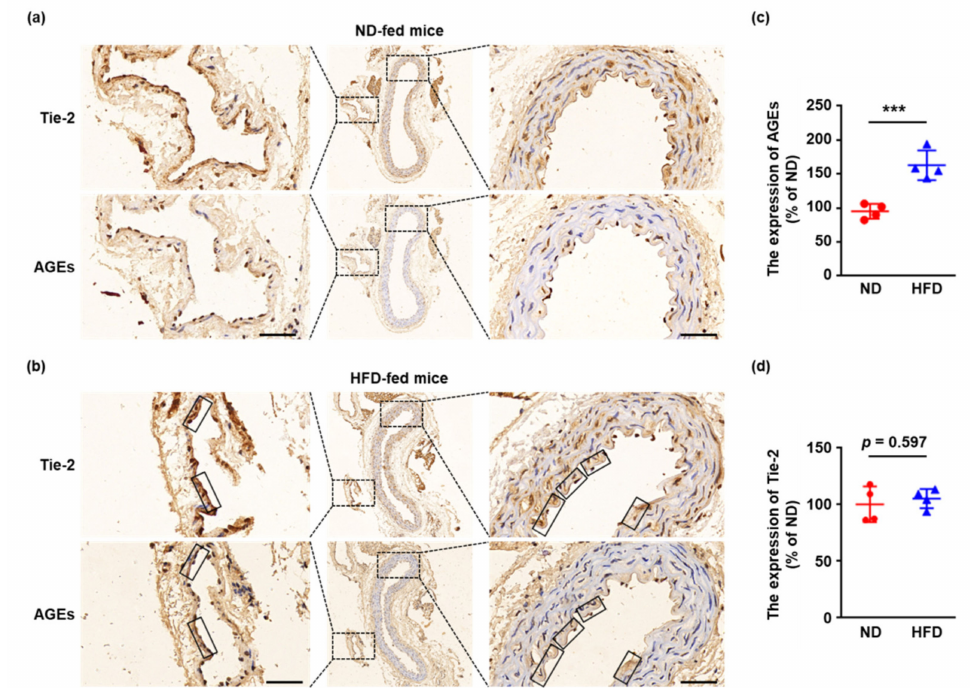
Figure 1. Tie-2 is glycated in HFD–fed mice. ( a ) The aortae derived from ND-fed C57BL/6J mice were isolated, fixed, embedded in paraffin, and sectioned. The Tie-2 and AGEs were then immuno- histochemically stained in two serial aortic sections. Distance bars, 50 µ m. Representative images are shown. n = 4. ( b ) The aortae derived from HFD-fed C57BL/6J mice were isolated, fixed, embedded in paraffin, and sectioned. The Tie-2 and AGEs were then immunohistochemically stained in two serial aortic sections. The solid black rectangles show the colocalization of Tie-2 and AGEs. Distance bars, 50 µ m. Representative images are shown. n = 4. ( c ) Quantitative assessment of AGE expression was performed. ( d ) Quantitative assessment of Tie-2 expression was performed. *** p < 0.001. Error bar represents the standard deviation and p value was generated by t